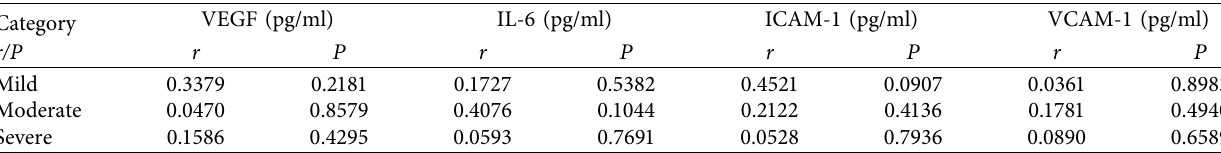
Table 4: Correlation analysis between BCVA and the expression levels of VEGF, IL-6, ICAM-1, and VCAM-1 in the aqueous humor.